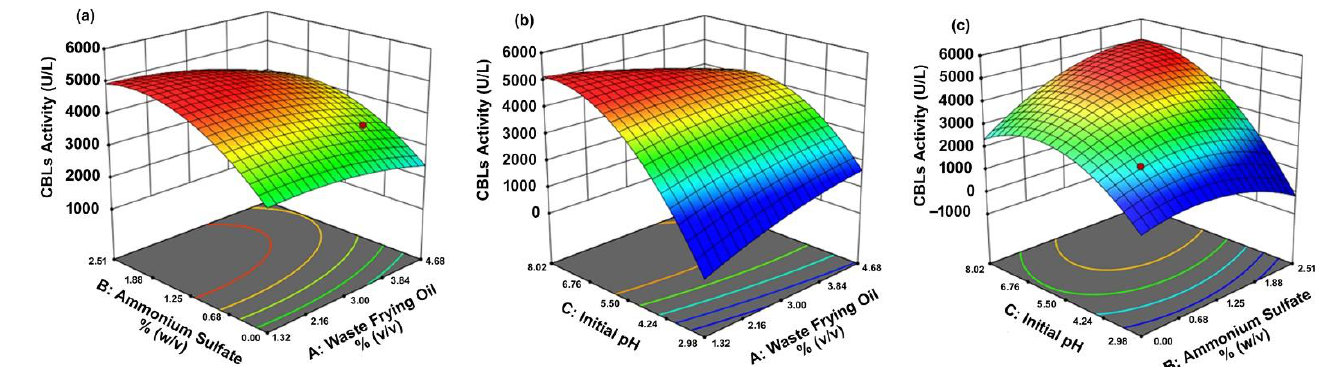
Figure 4. Response surface plots described by the model for the CBLs production by the co-culture of M. spicifer AW2 and S. hominis AUP19 in oily wastes medium, representing the interactive effect between variables, i.e., AB: waste frying oil (WFO) with ammonium sulfate (AS) ( a ), AC: WFO with initial pH ( b ), and BC: AS with initial pH ( c ). The interaction of WFO with initial pH or AC and AS with initial pH or BC were significant, with a p -value of 0.0416 and 0.0206, respectively. The three-variable models expressing the interactions among the variables representing the responses were obtained, and ANOVA was employed to evaluate the statistical significance of equations for the quadratic response model (Supplementary Materials, Tables S5–S7).